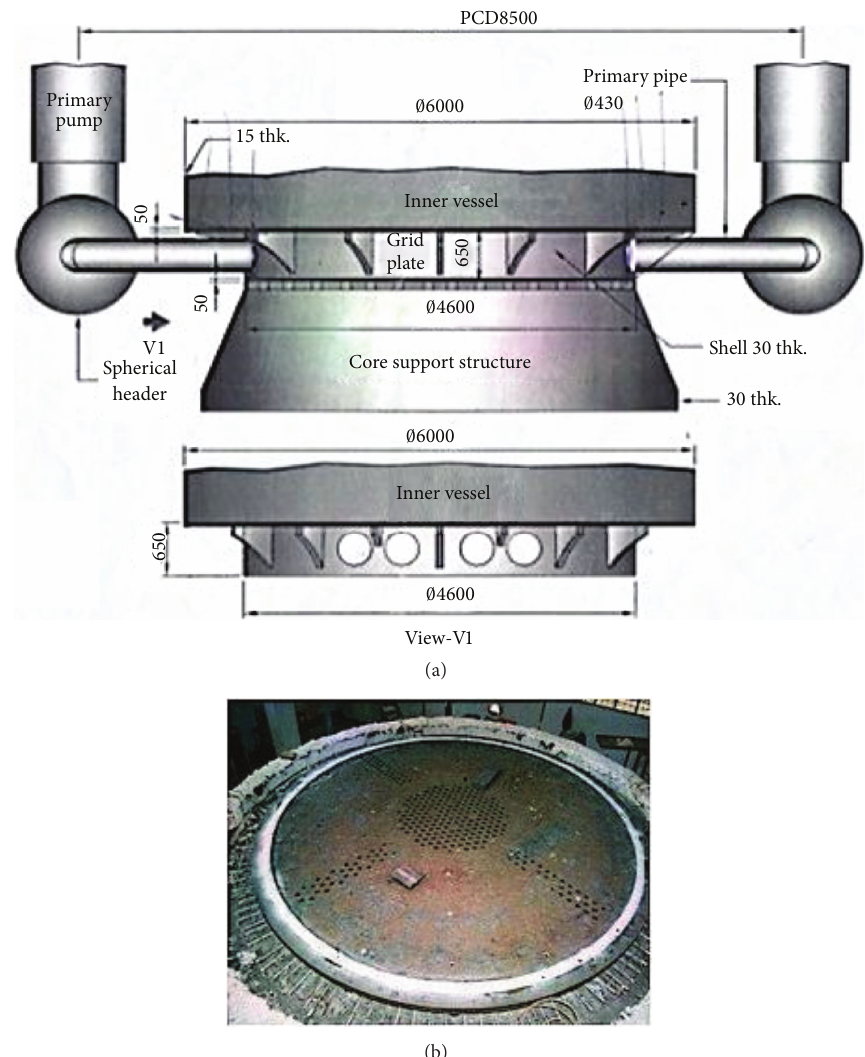
Figure 1: (a) Grid plate-primary pipe-CSS assembly. (b) Bottom of the grid plate assembly after hardfacing.